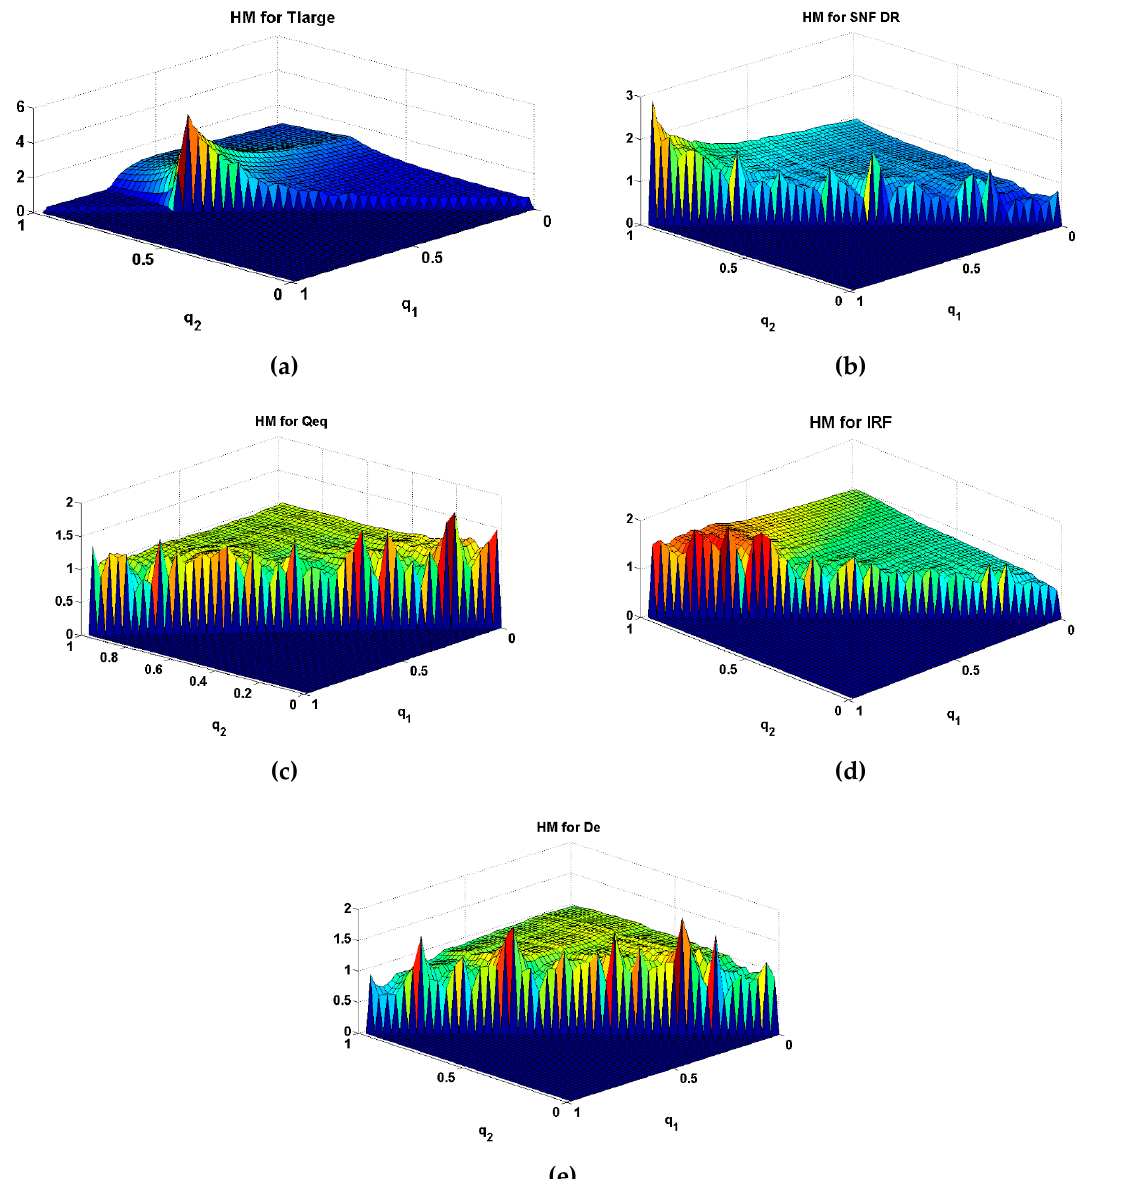
Figure 7. 3D plots of the revised mean ratio function (HM) for all parameters at t 5 = 5 × 10 4 years: ( a ) defect size enlargement time (Tlarge); ( b ) SNF dissolution rate (SNF DR); ( c ) equivalent groundwater flow rate around the canister (Qeq) (m 3 /year); ( d ) instant release fraction (IRF) of I-129; ( e ) effective diffusivity of I-129 in bentonite(De) (m 2 /s).